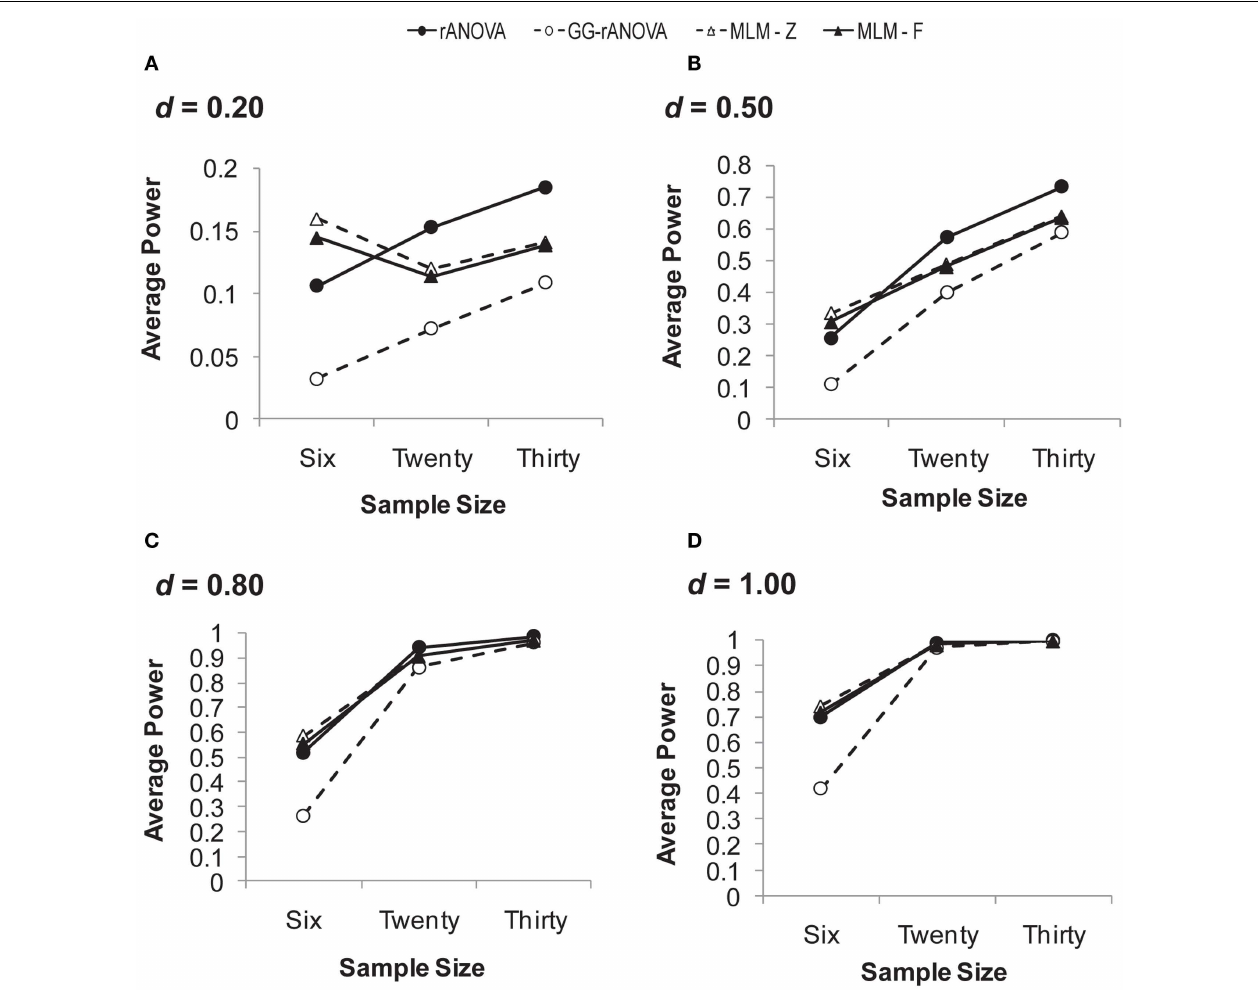
rANOVA = repeated measures ANOVA, GG-rANOVA is Greenhouse–Geisser corrected repeated measures ANOVA, MLM- Z ,Wald’s Z from the MLM, MLM- F is the between-within df for F from the